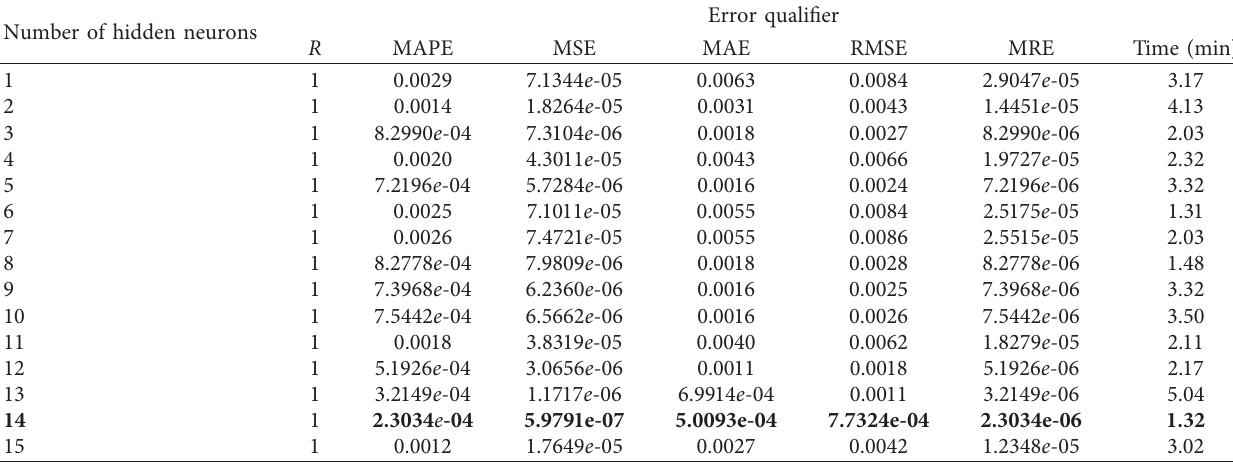
Table 4: The proposed five input-based multilayer perceptron neural network statistical performance analyses with various hidden neurons for solar irradiance forecasting.